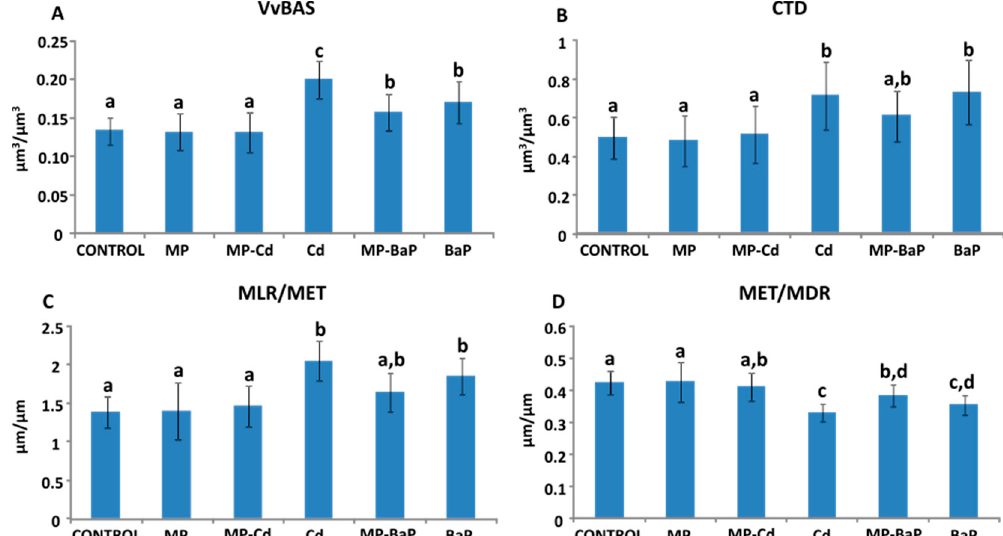
Figure 7. Results of the quantitative histological analysis of the structure of the digestive gland. ( A ) Volume density of basophilic cells; ( B ) connective-to-diverticula ratio; ( C ) mean luminal radius to mean epithelium thickness; ( D ) mean epithelium thickness to mean diverticular radius. Mean ± standard deviation ( n = 10). Different letters indicate statistically significant differences ( p < 0.05) according to the Tukey’s post hoc test after one-way ANOVA.